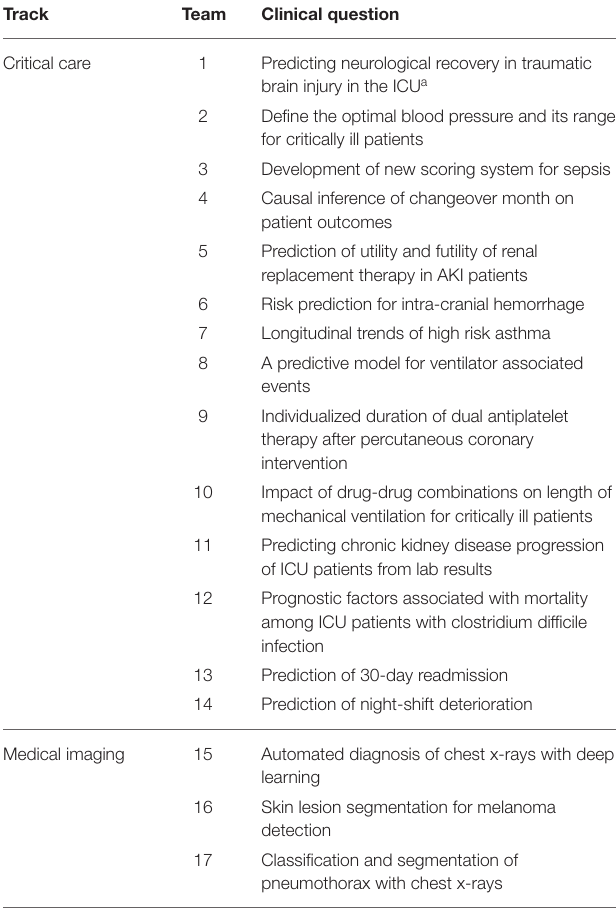
TABLE 1 | Singapore AI healthcare datathon and expo 2019 project list.